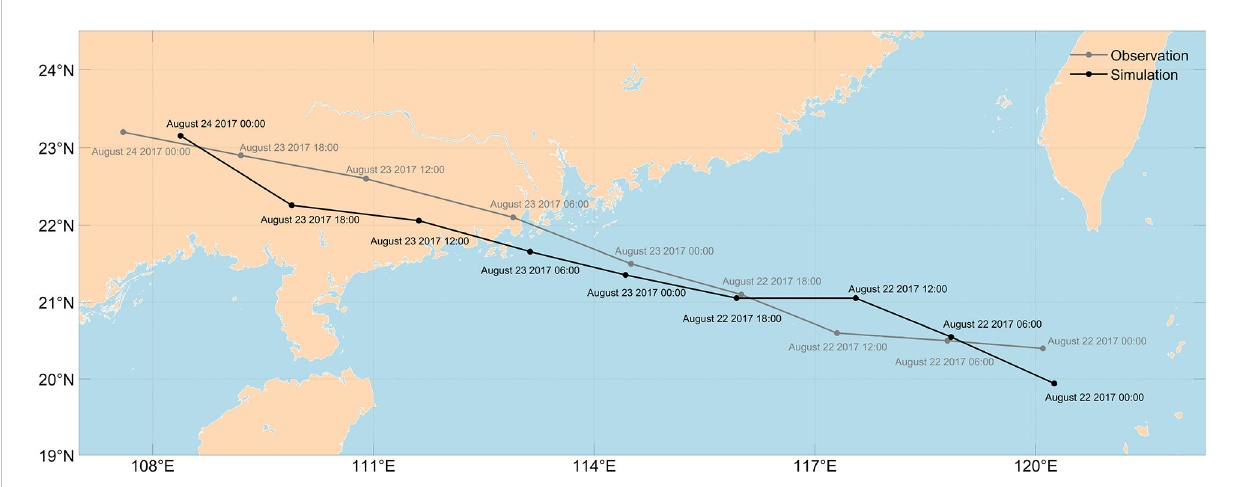
FIGURE 9 The observed and simulated track of Hurricane Hato (2017). The six-hour best-track TC data were obtained from the Shanghai Typhoon